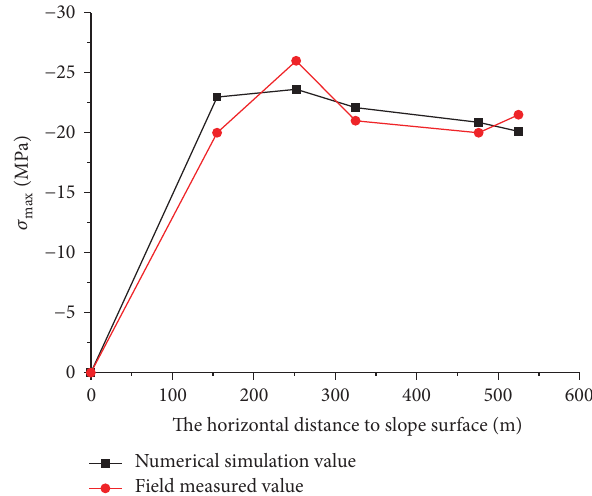
Figure 11: Comparative curves of in situ stress values between field measurement and numerical